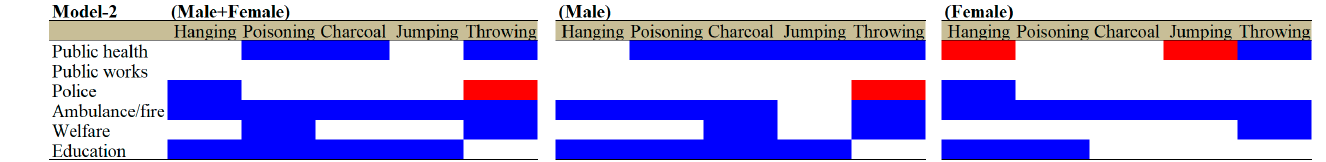
Figure 2. Impacts of expenditure of six divisions per capita (public health, public works, police, ambulance/fire, welfare and education) prefectures/municipalities on suicide mortalities by five major suicide means (hanging, poisoning, charcoal burning, jumping and throwing suicide) of both gender (males plus females), males and females between 2009 and 2018 using fixed- or random-effect analyses of hierarchal linear regression with robust standard error. Blue and red columns, significant factors for decreasing and increasing suicide mortalities.